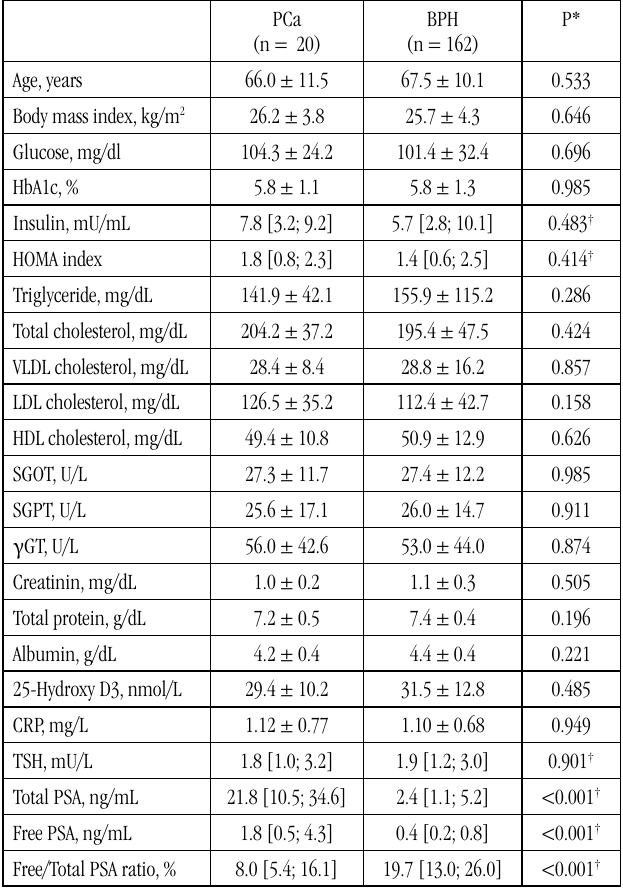
TABLE 1 - Clinical and biochemical serum characteristics of the individuals according to the diagnosis of prostate cancer (PCa) or benign prostatic hyperplasia (BPH)